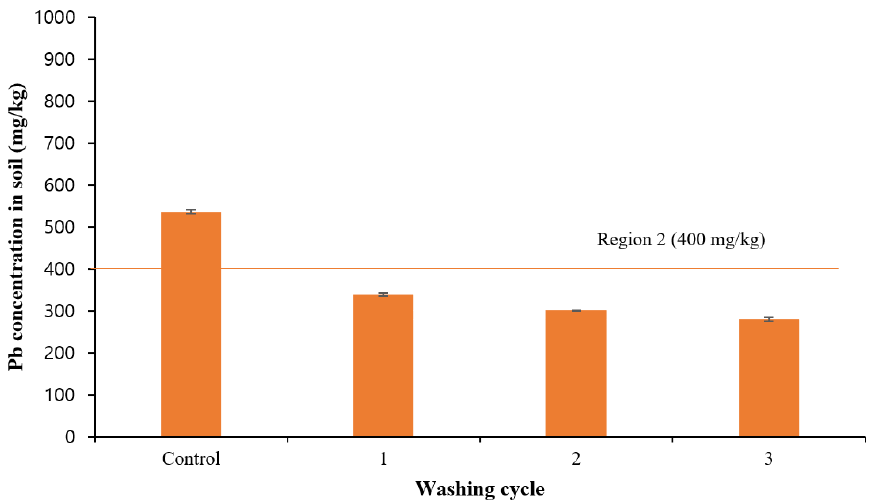
Figure 10. Pb concentrations remaining in the soil after 1, 2 and 3 high-pressure washing cycles.